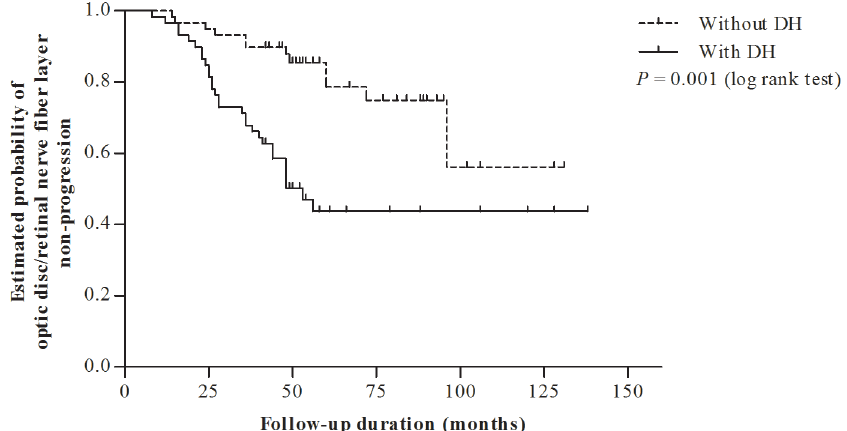
Fig 1. Kaplan–Meier analysis of estimated probability of optic disc/retinal nerve fiber layer (RNFL) non-progression in patients with disc hemorrhage (DH) versus those without DH. The cumulative probabilityof optic disc/RNFL non-progression (10-year survival rate: 0.44 ± 0.01) was significantly lower in the DH group than in the non-DHgroup (10-year survival rate: 0.47 ± 0.12) (P = 0.001, log rank test).